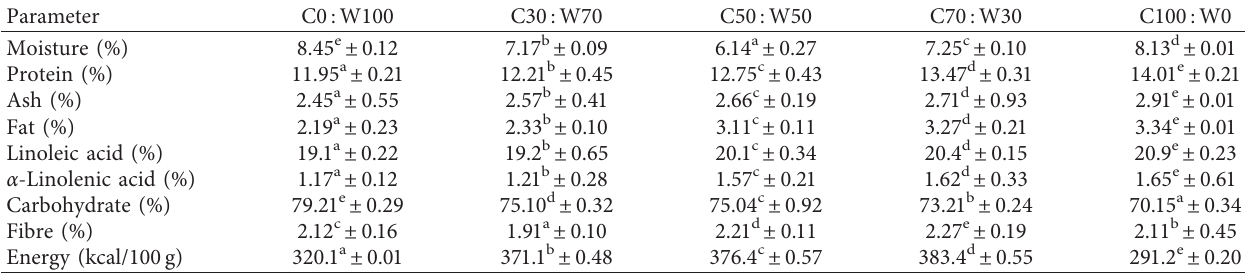
Table 2: Proximate compositions of wheat bread samples with different concentrations of camel milk.